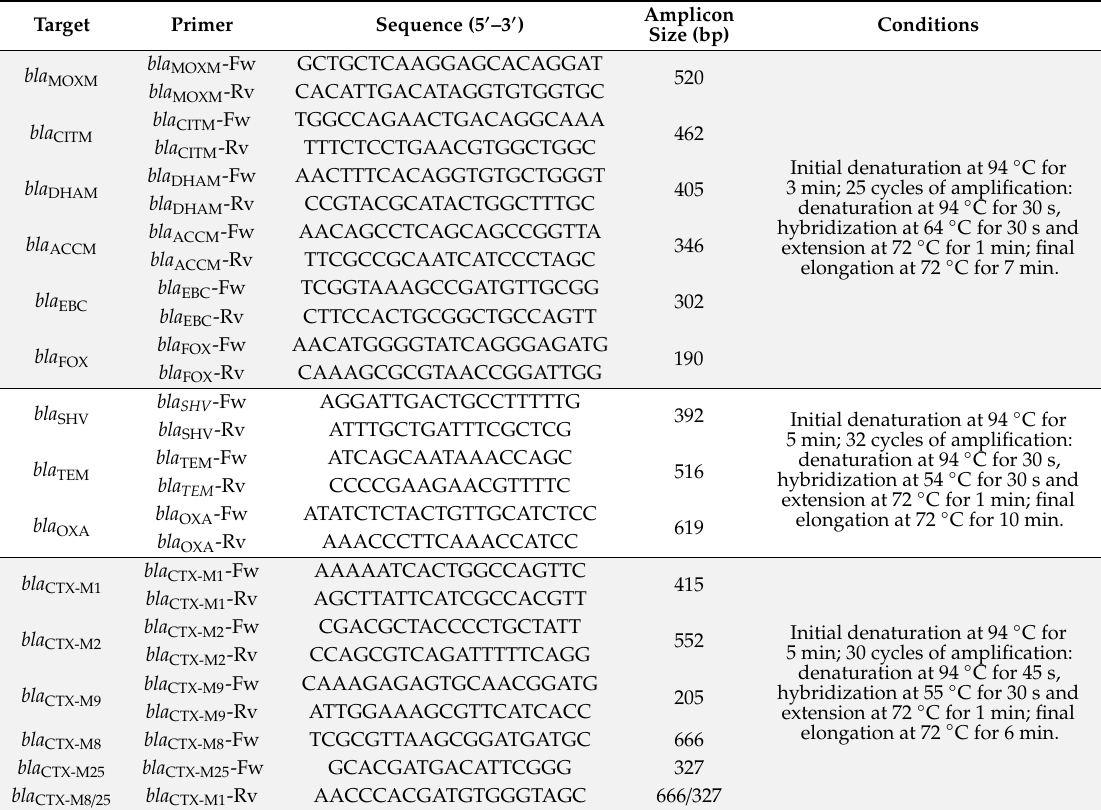
Table 1. Primers and conditions used for the amplification of the di ff erent β -lactamases genes.